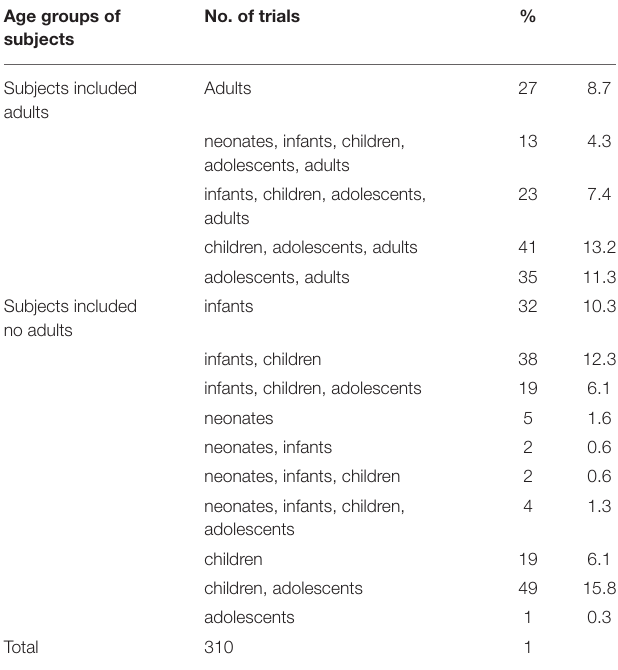
TABLE 5 | Distribution of clinical trials by different age